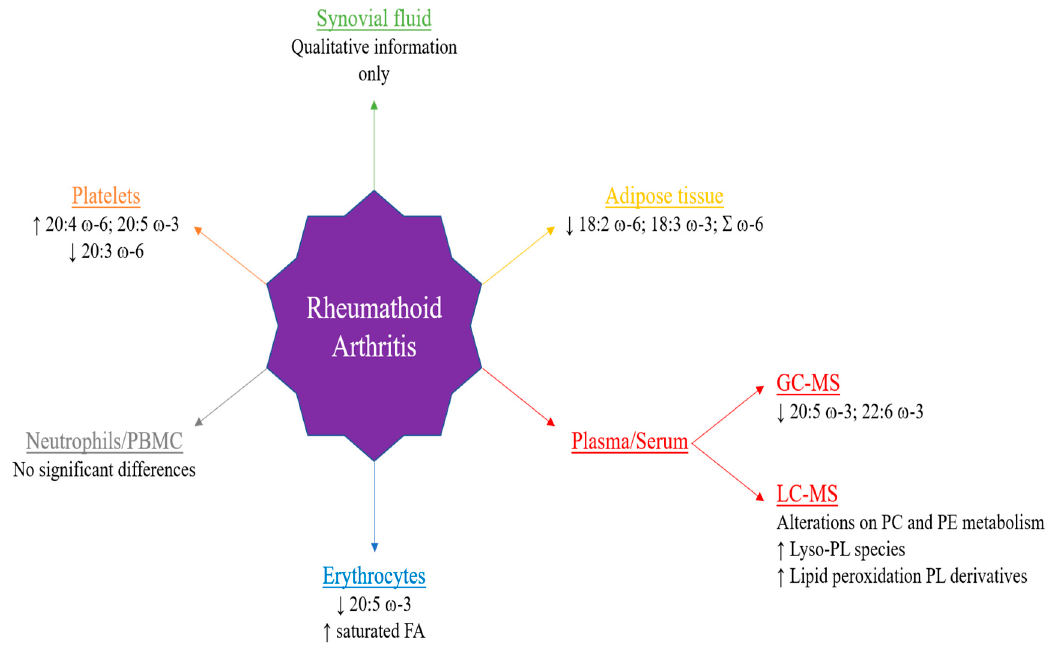
Figure 2. Main lipidomic alterations described in several studies reported in this review. PBMC: peripheral blood mononuclear cells; GC-MS: gas-chromatography mass spectrometry; LC-MS: liquid-chromatography mass spectrometry.